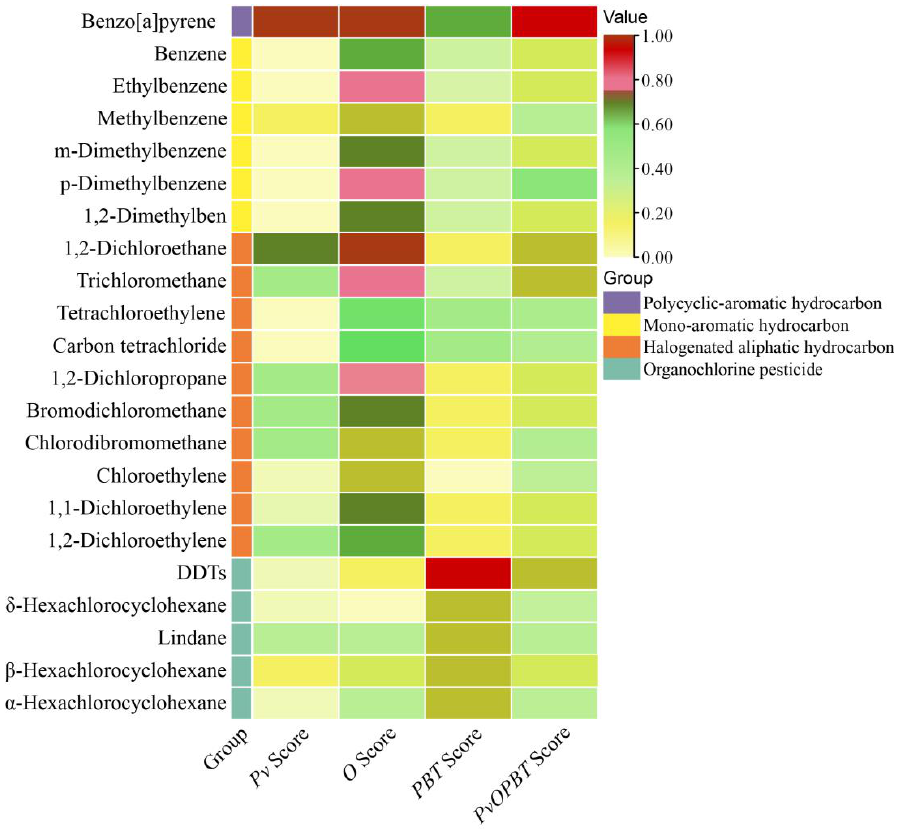
Figure 3. Classification and evaluation scores of organic pollutants in groundwater.